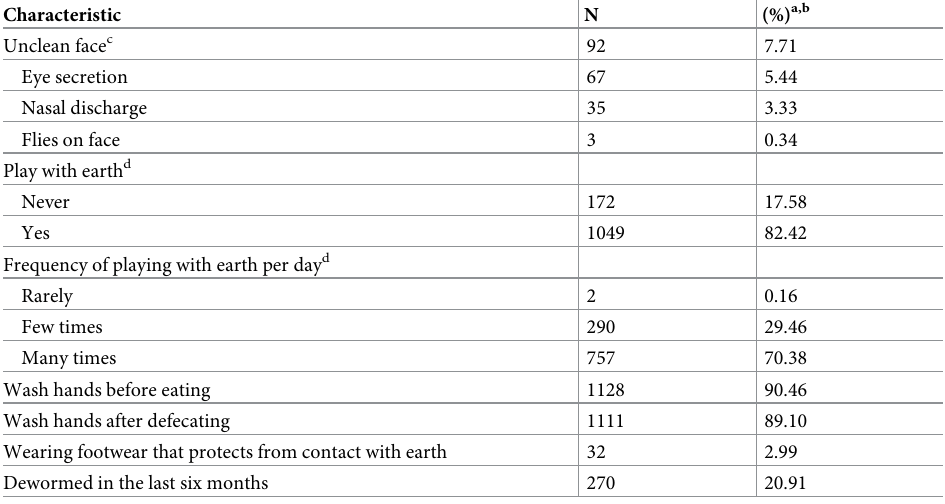
Table 6. Individual-level factors for trachoma and soil-transmitted helminthiases of children aged 1–9 years examined in rural communities of Loreto Department, Peru, 2017. Characteristic N (%) a,b Unclean face